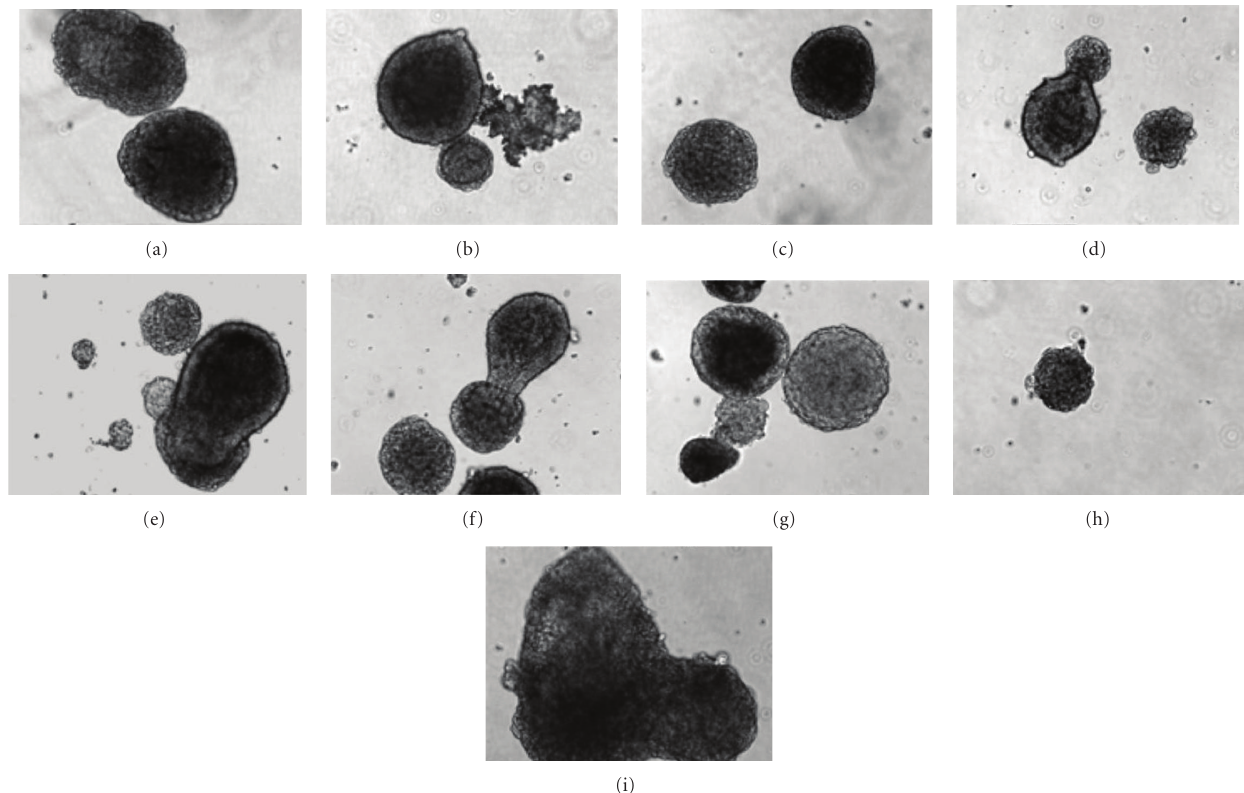
Figure 2: Embryoid body formation. Embryoid bodies tend to form structures similar to those seen in normal embryonic development (yolk sac, amniotic sac, etc.). The embryoid bodies vary in shape, size, and